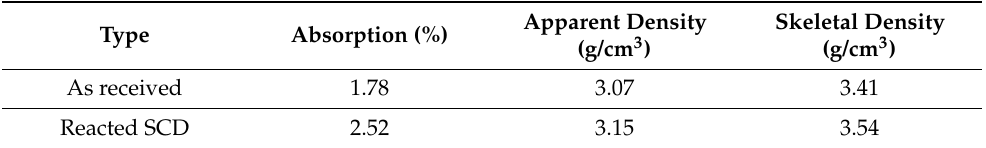
Table 4. Absorption, apparent density, and skeletal density of converter slag reacted with supercritical carbon